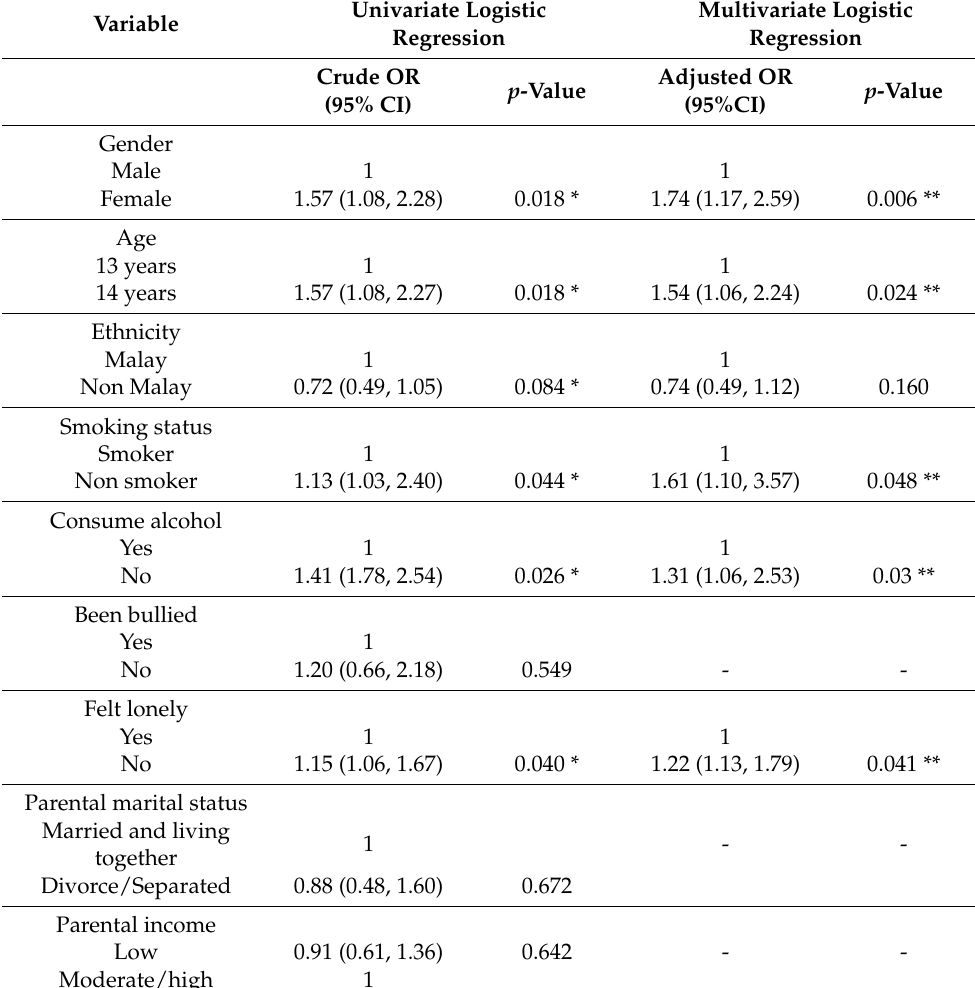
Table 2. Factors associated with correct recognition of the mental health disorder (depression). Univariate Logistic Multivariate Variable Regression